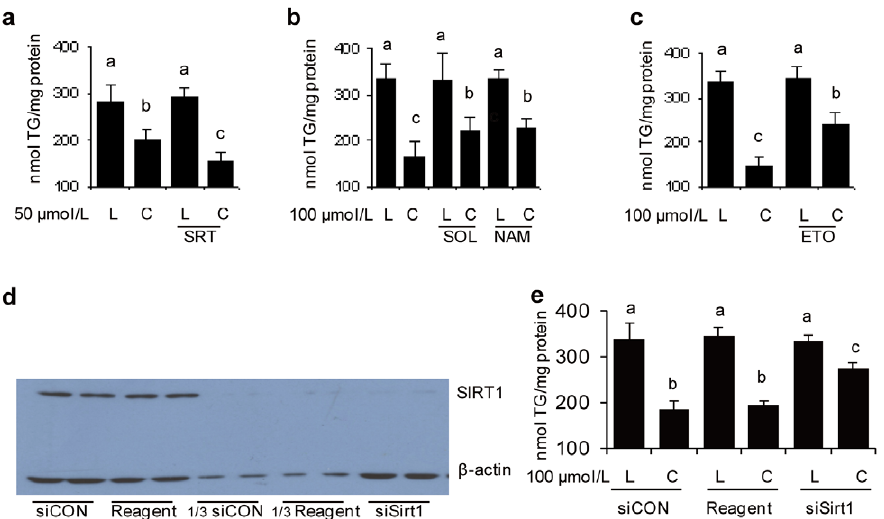
Figure 1. SIRT activity affects TG levels in t 10 c 12 CLA treated 3T3-L1 adipocytes. a–c Triglyceride (TG) levels were measured in differentiating adipocytes after incubation with LA (L) or t 10 c 12 CLA (C), with or without the SIRT1 activator SRT1720 (SRT), or the sirtuin inhibitors sirtinol (SOL), nicotinamide (NAM), or etomoxir (ETO) for 24 h. d Immunoblot analysis of whole cell extracts for the amount of SIRT1 and b -actin proteins after exposure to 80 nmol/L of control siRNA (siCON), or siRNA against SIRT1 (siSirt1), or transfection reagent only. Duplicate loadings of each sample were analyzed and the lanes marked by 1/3 have one third of the indicated samples loaded. e Triglyceride (TG) amounts after treatments as in d . Each bar in panels a–c and e represents the mean + SEM (n=3), and is representative of three independent experiments. Means not sharing a common letter differ, P ƒ 0.05. Panel d is a representative blot of three independent experiments.